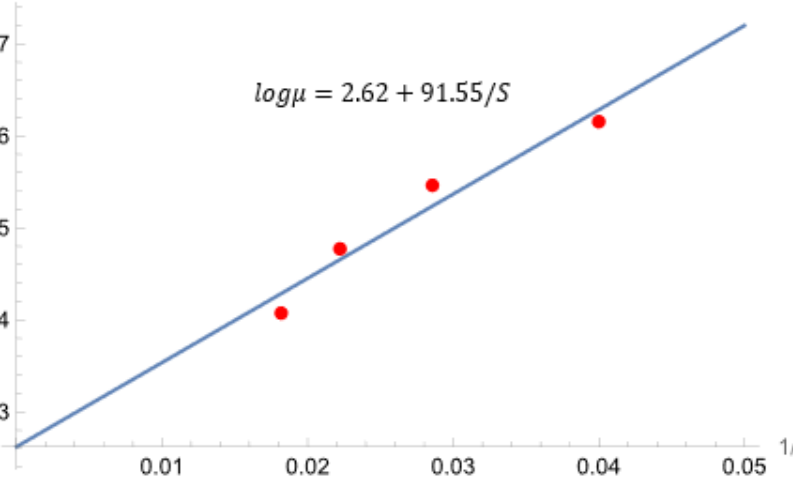
Figure 1. Life characteristic curve.